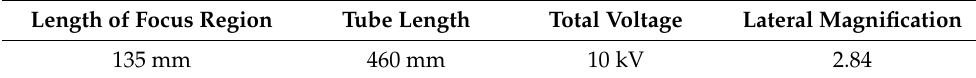
Figure 3. Structural diagram of streak tube. Table 1. The parameters of streak tube.